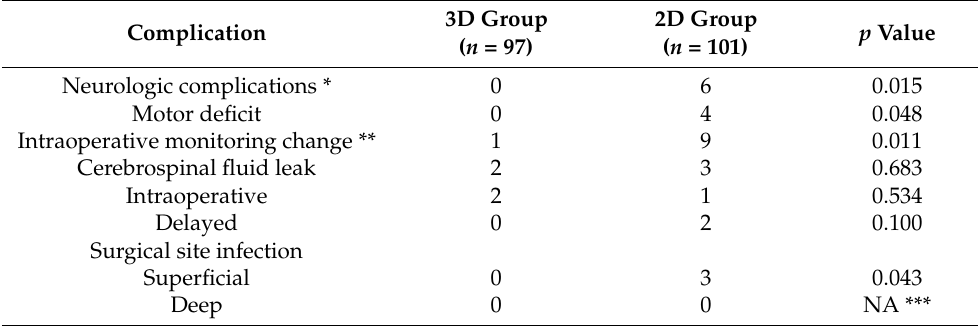
Table 2. Complications in the study groups.